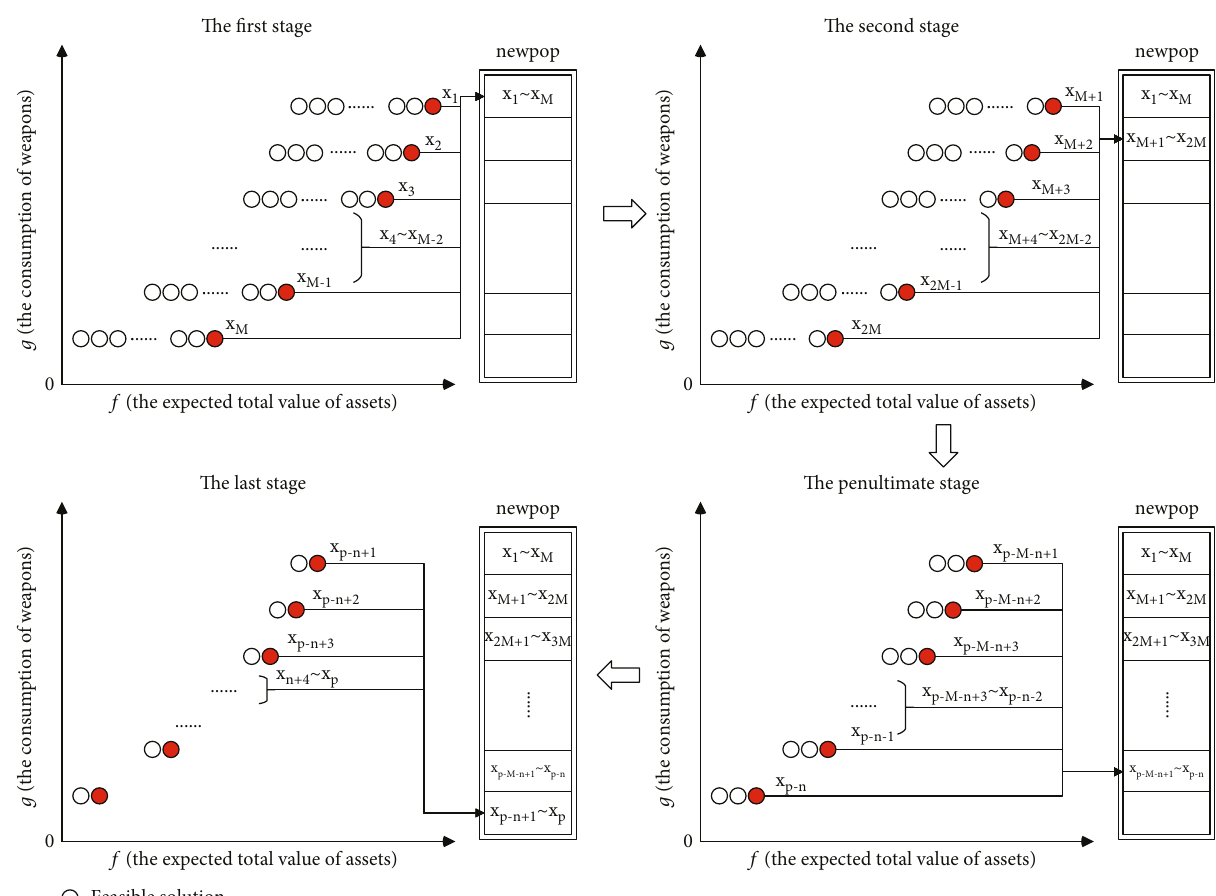
Figure 7: Selection